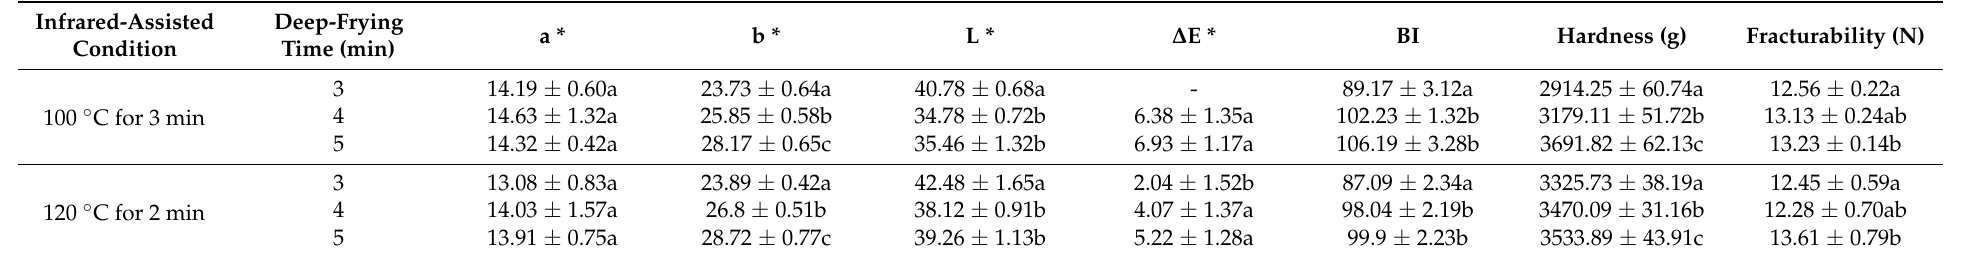
Table 3. Effect of deep-frying time on color parameters, hardness, and fracturability of fried dough twist (FDT) in different an infrared-assisted condition. Infrared-Assisted